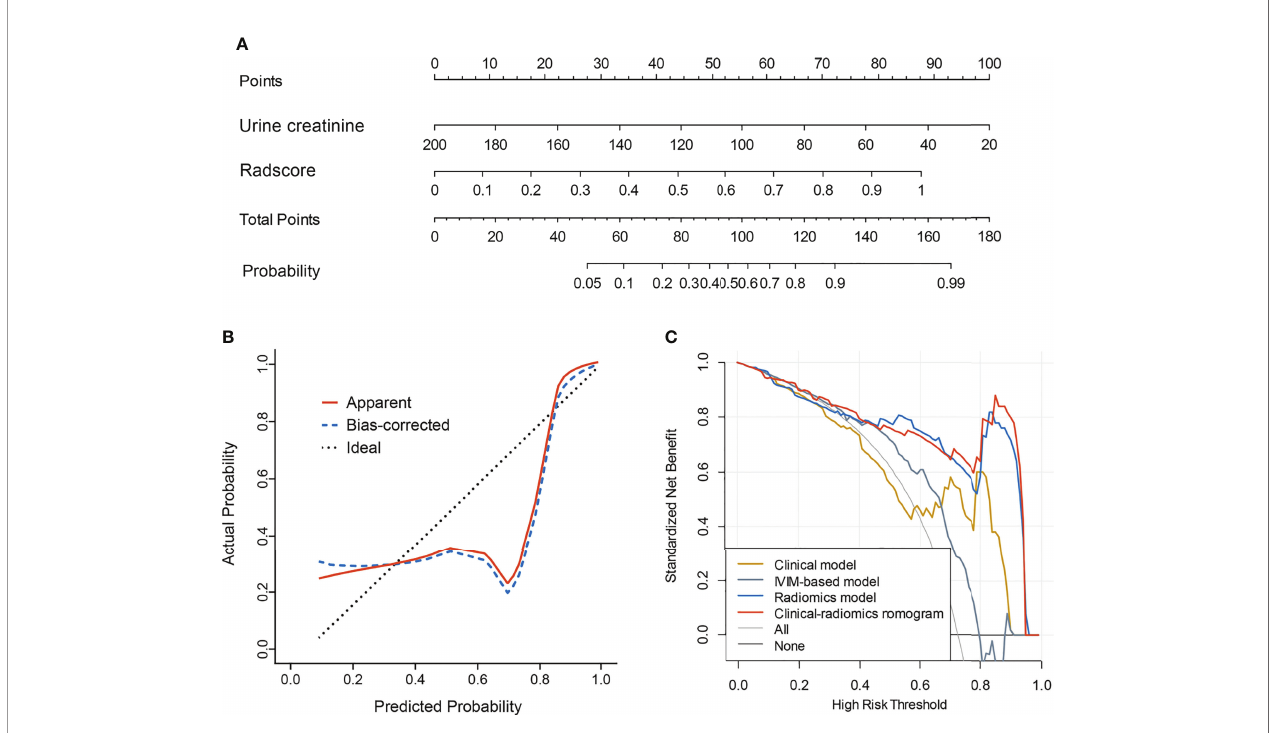
FIGURE 5 | Clinical-radiomics model and its performance. (A) Nomogram based on urine creatinine and radscore; (B) Calibration curves for nomogram; (C) Decision curve analysis for clinical model, IVIM-based model, radiomics model, and the clinical-radiomics